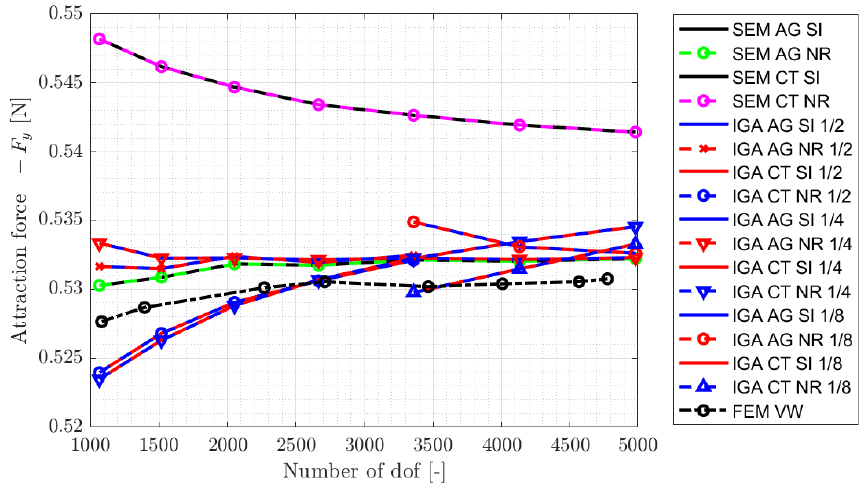
Figure 4. Convergence of the attraction force for Benchmark I for different